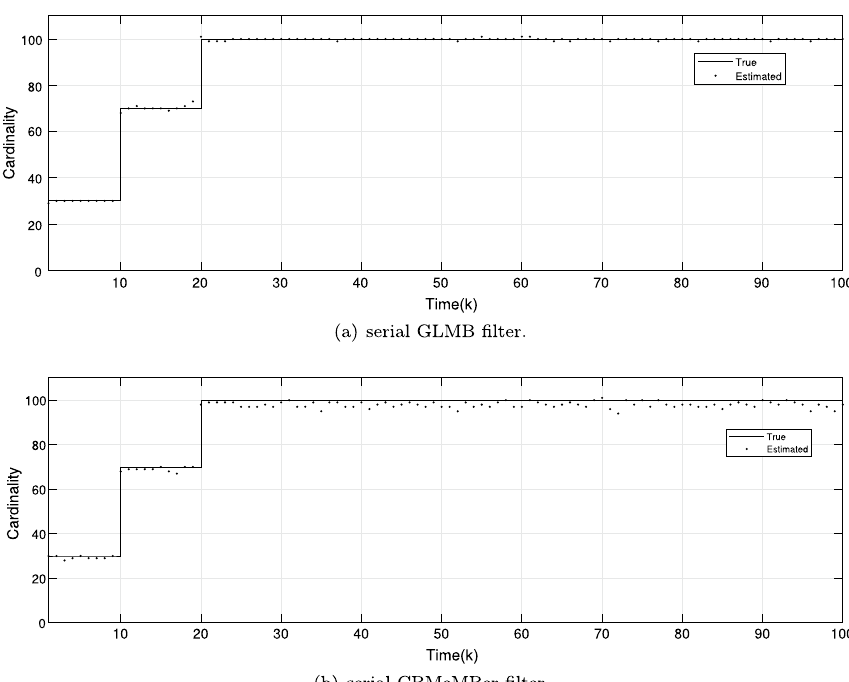
Fig. 10 Estimation of the number of all